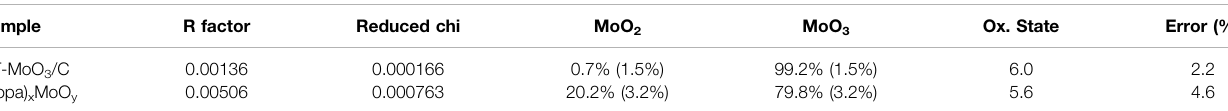
TABLE 1 | LCF results of XANES spectra.